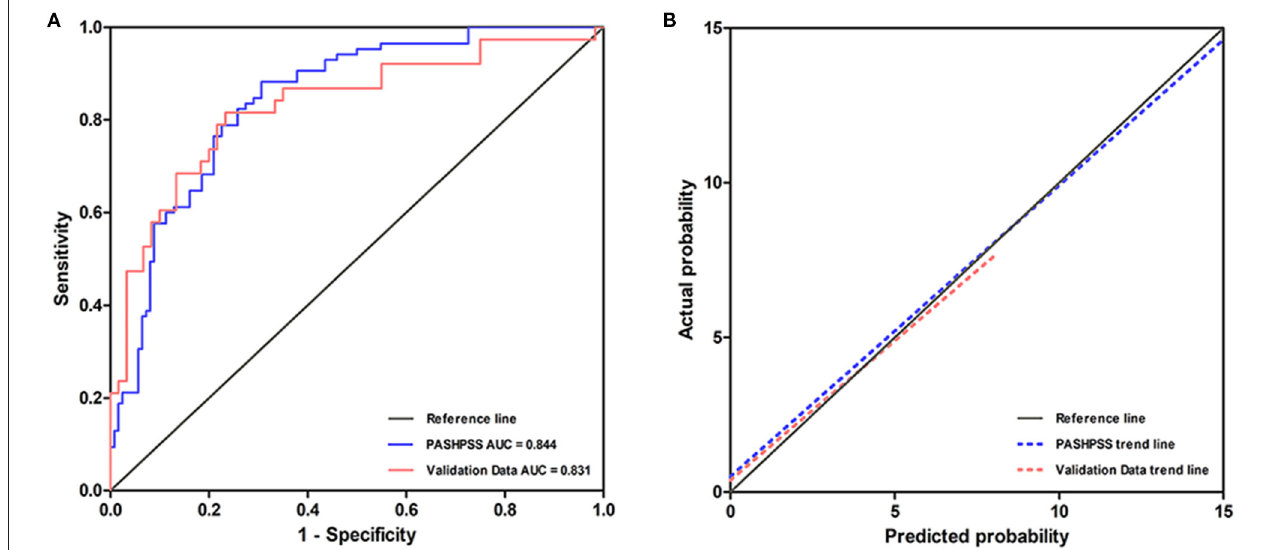
FIGURE 3 | (A) The AUC of the PASHPSS is 0.844 (95% CI, 0.778–0.909) in our center’s derivation data, while it is 0.831 (95% CI, 0.732–0.929) in validation data. (B) A slope of 1 (45 degrees) with an intercept of 0 represents perfect calibration, the deviation from the reference line is smaller, the calibration is better. PASHPSS has a good calibration in derivation cohort and validation